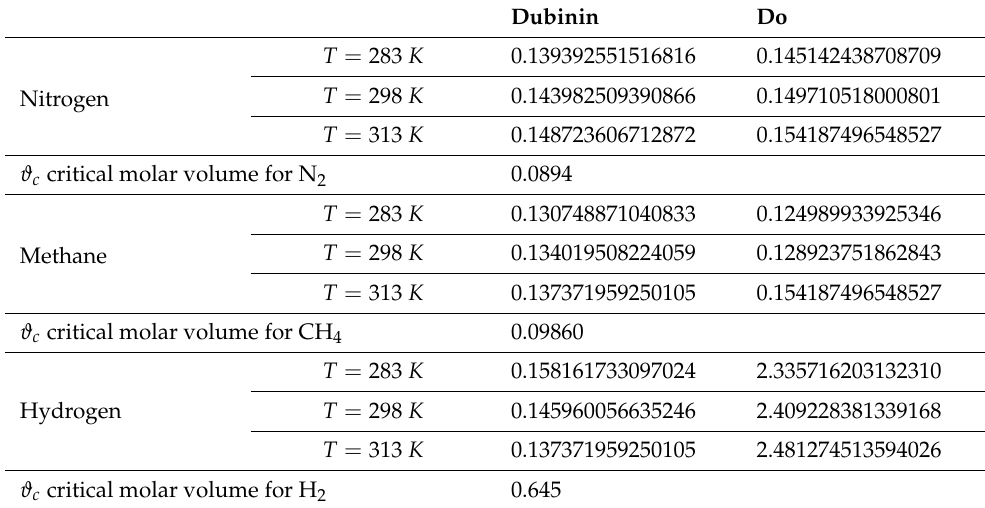
Table 5. Adsorbate molar volume (l/mol) calculated by two models.